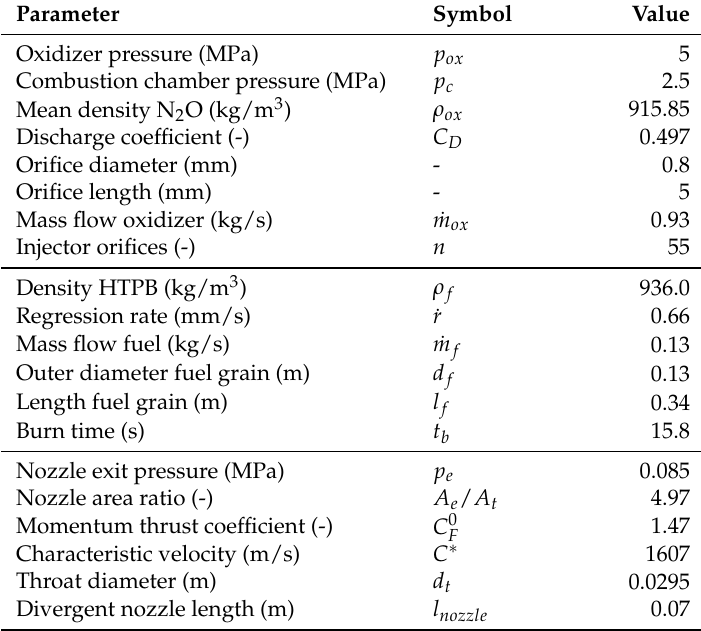
Table 4. Design data of HYDRA